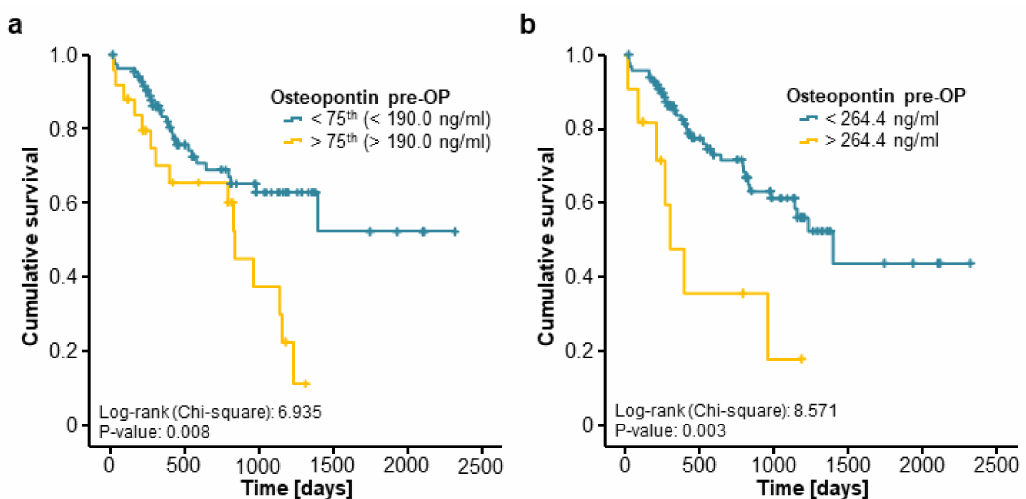
Figure 3. Elevated preoperative levels of circulating osteopontin are associated with a reduced overall survival after resection of colorectal liver metastases. ( a ) Patients with high preoperative osteopontin concentrations (>75th percentile) show a significantly impaired overall survival (OS) compared to patients with low osteopontin levels (log-rank test, p = 0.008); ( b ) Patients with initial osteopontin serum above our established ideal cut-off value (264.4 ng/mL) show a strikingly reduced median OS of 304 days compared to 1394 days for patients with osteopontin serum levels below this cut-off (log-rank test, p =